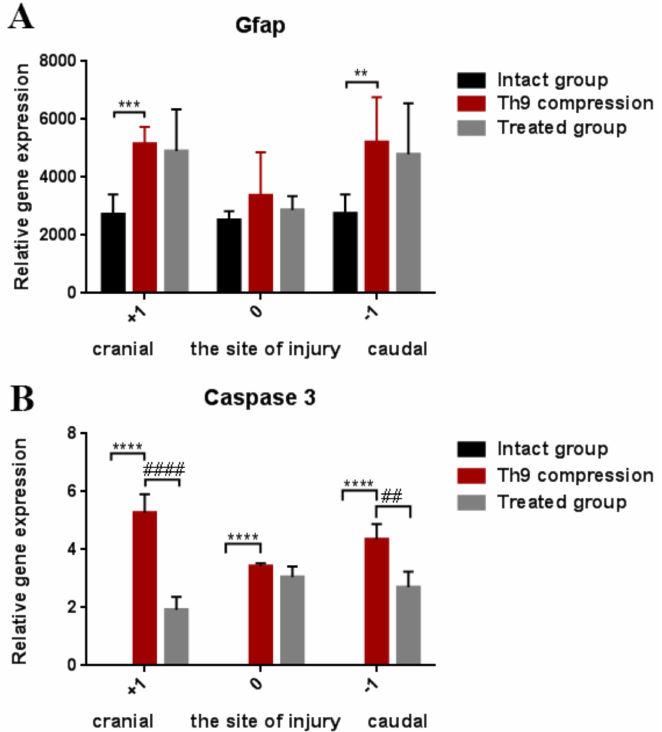
Figure 4. Gene expression showing astrogliosis (GFAP) and apoptosis (caspase-3) in the spinal cord 24 h after the Th9 compression and the atorvastatin (5 mg/kg; i.p.) treatment. The graphs show the relative quantities of GFAP ( A ) and caspase-3 ( B ) in rostro-caudal manner in the controls and 24 h after the SCI and SCI + ATR treatment. Data are the mean values of five experiments ± SD. The results were statistically evaluated using one-way ANOVA; ** p < 0.01; ## p < 0.01; *** p < 0.001; **** p < 0.0001; #### p < 0.0001. Atorvastatin—ATR; GFAP—astrocytes; SCI—spinal cord